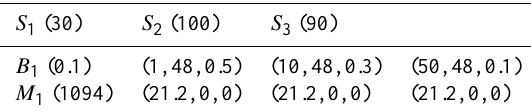
Table 1. Parameter values for microbial models S3B1 and S3B1M1. The parameter vectors are presented in the form whose units are, respectively, mgCdm − 3 , d − 1 , and none. The ini- tial microbial biomass is defined in the parentheses after B 1 , whose unit is mgCdm − 3 . The mineral surface is characterized with the Langmuir dissociation parameter (equivalently K S ,ij ) and the max- imum adsorption capacity (in the parentheses following M 1 ) , whose units are, respectively, mgCdm − 3 and mgCdm − 3 . For both mod- els, we used a microbial respiration rate 0.03d − 1 . The microbial parameters were randomly specified based on prior knowledge from Wang et al. (2012), and the mineral surface parameters were speci- fied for Alfisol based on Mayes et al. (2012).